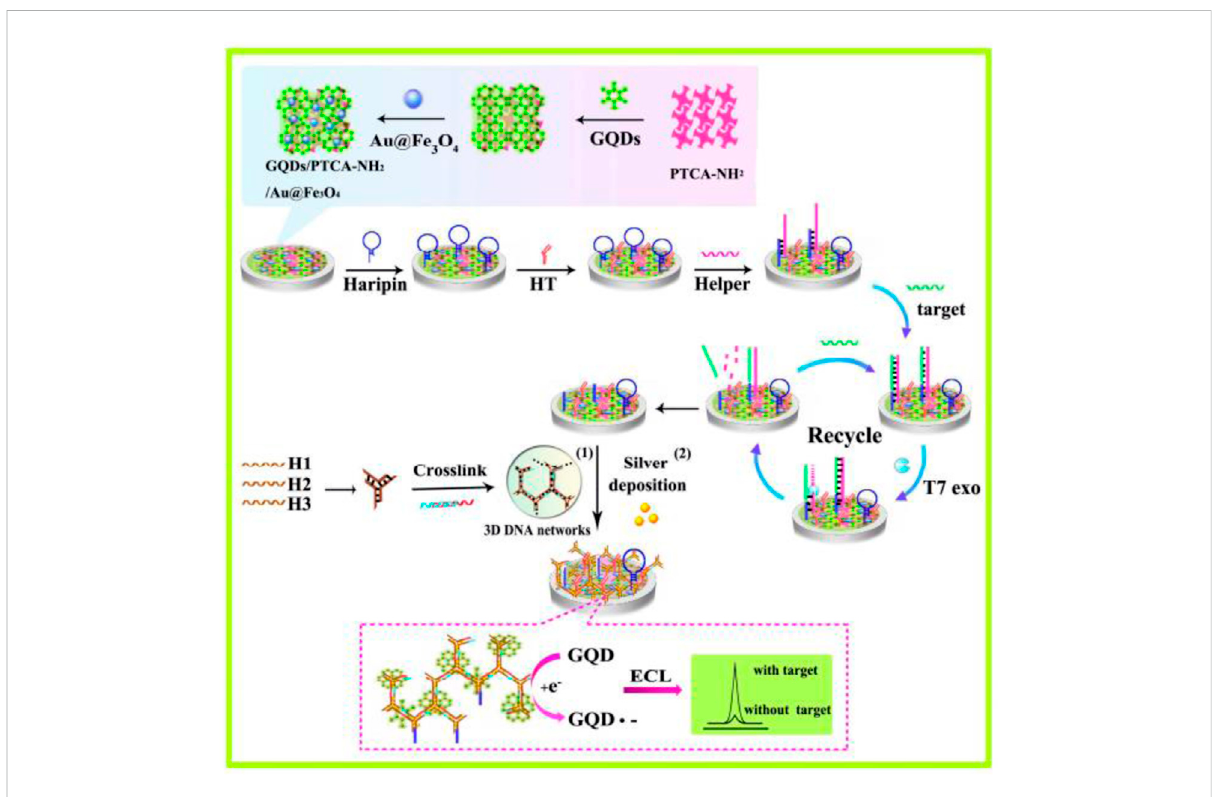
FIGURE 3 Working mechanism ofelectrochemiluminescentgraphene quantum dots sensing platformfor thedetection of miRNA-21 (Zhang etal., 2015). Copyright 2015 American Chemical